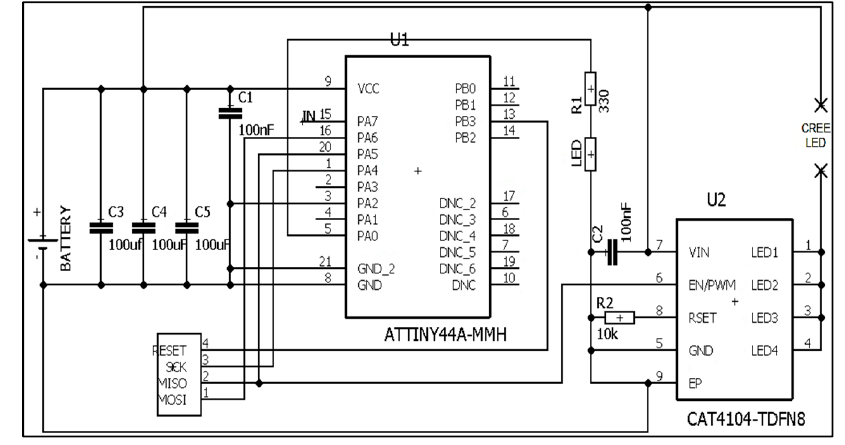
Figure 5. Schematic of the optogenetic stimulator.